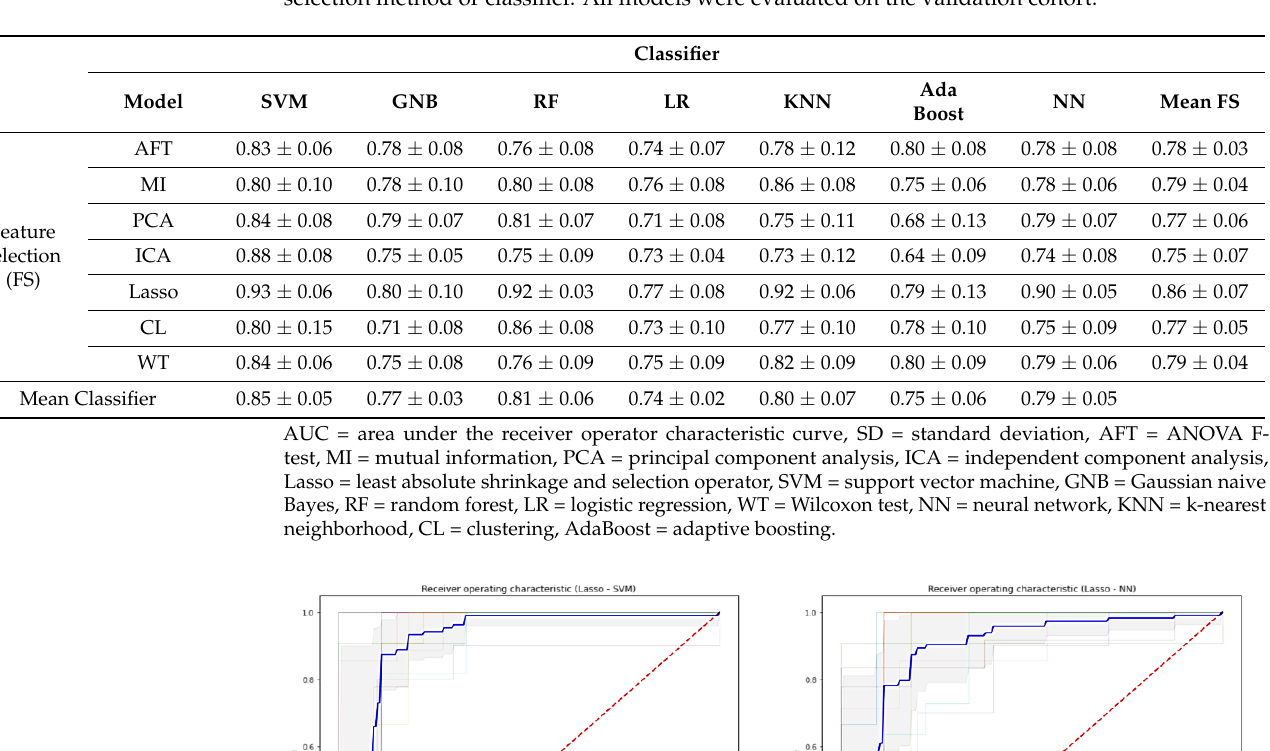
methods had higher performance, 0.85 ± 0.05 and 0.86 ± 0.07, respectively. The ROC curves of the 10-fold cross-validation for Lasso + SVM and Lasso + NN are plotted in Figure 4. Table 5. Cross-validation performance of all predictive models (FS + Classifier) in terms of the AUC. Values indicate the AUC ± SD of each model or mean AUC ± one SD for a determined feature selection method or classifier. All models were evaluated on the validation cohort.